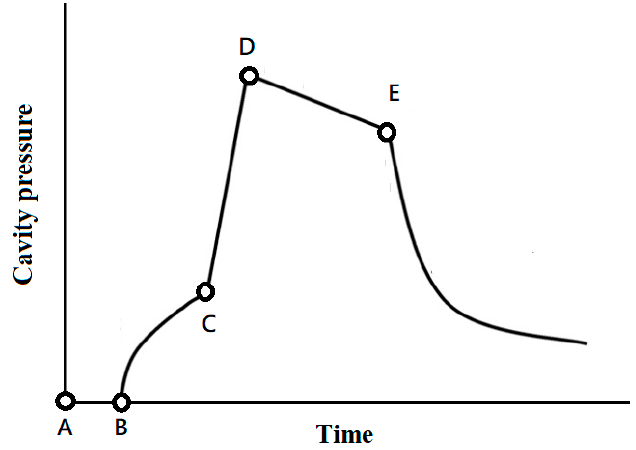
Figure 1. Typical cavity pressure profile.